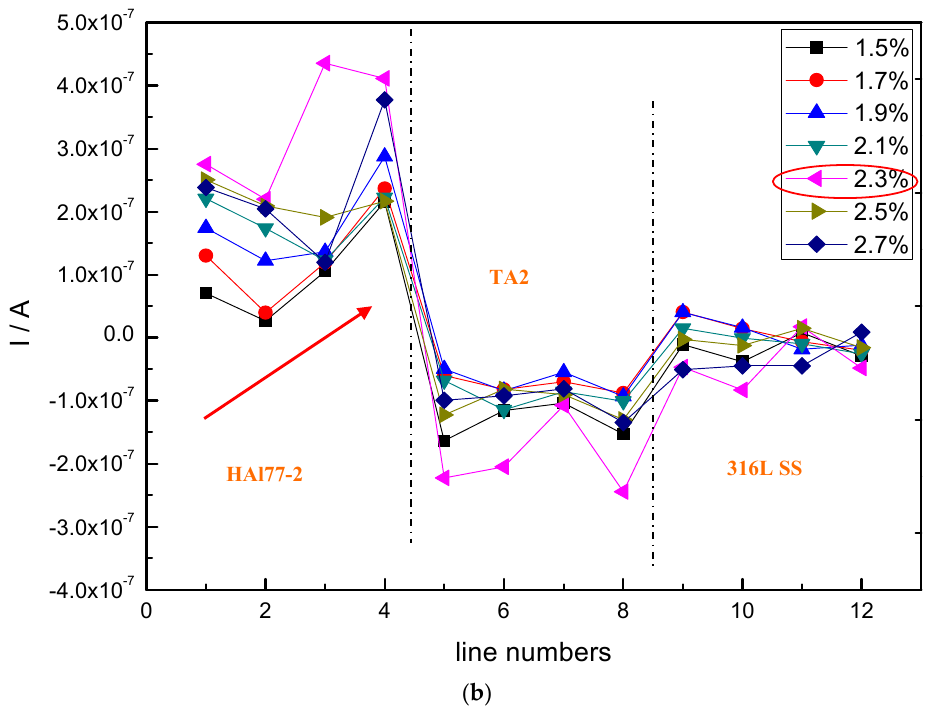
Figure 10. Potential and corresponding current distributions of each CMEA2 microelectrode line after being short-circuited for 12 h in artificial seawater with different chloride concentrations (wt %): ( a ) average potential; and ( b ) average current.